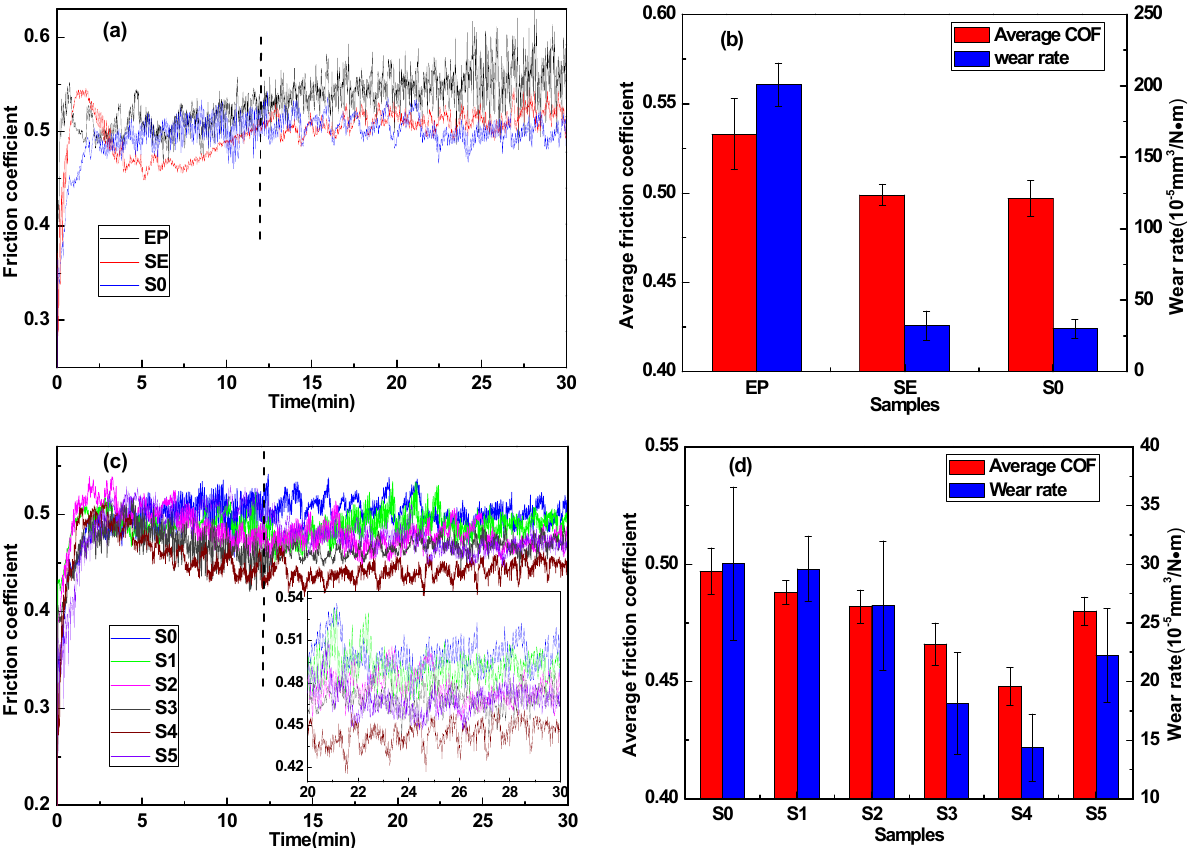
Figure 5. Development of friction coefficient over testing time for EP composites ( a , c ), and average COF and wear rate for EP composites at 60 N ( b , d ).